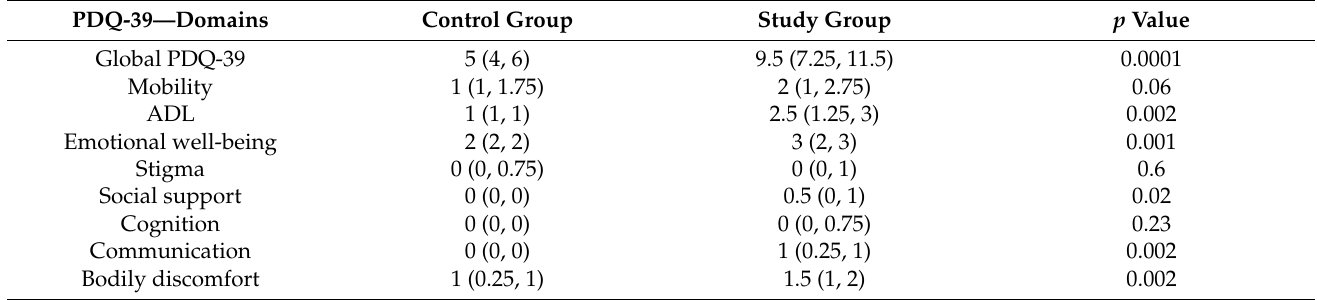
Table 5. Comparison of the median values of differences (initial value—final value) between the study group and the control